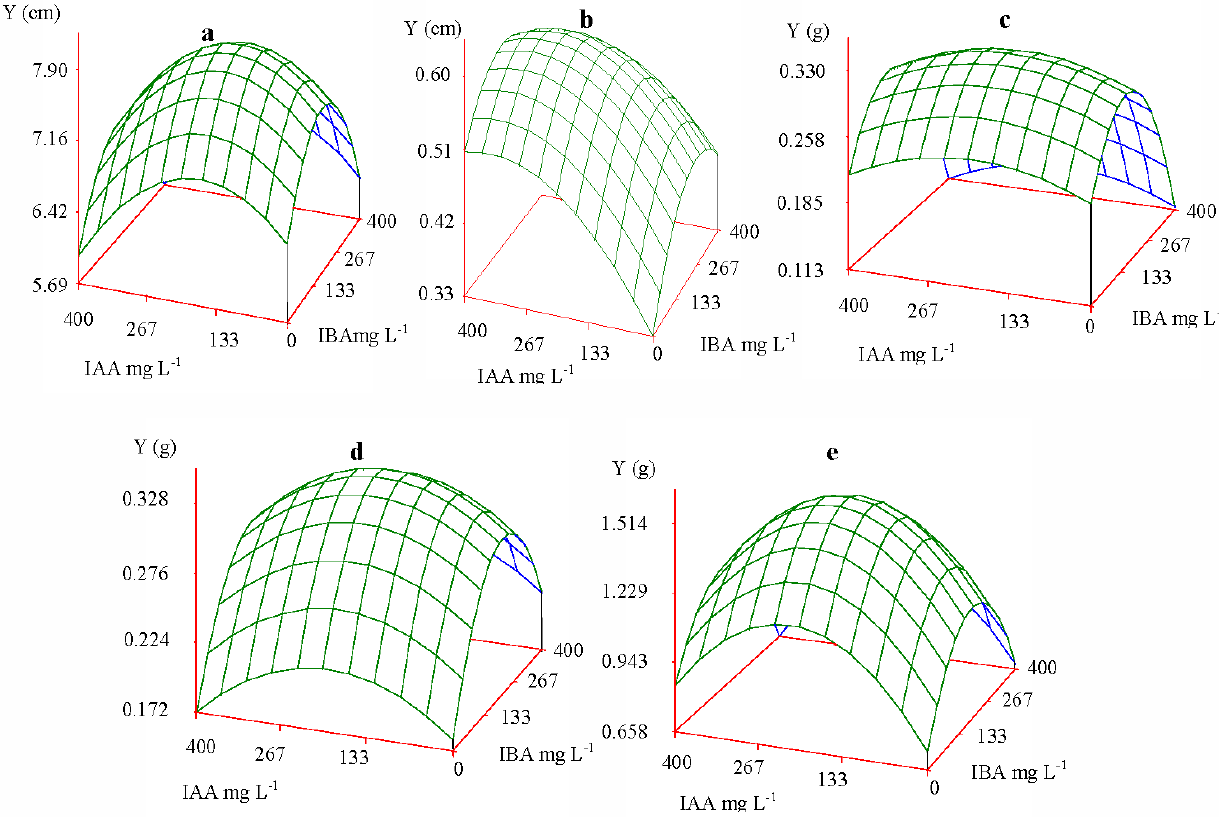
Figure 1. Growth index response of Yunnan pine to exogenous treatment with indoleacetic acid ( IAA) and indolebutyric acid (IBA) solution. ( a ) height; ( b ) collar diameter; ( c ) root biomass; ( d ) stem biomass; ( e ) needle